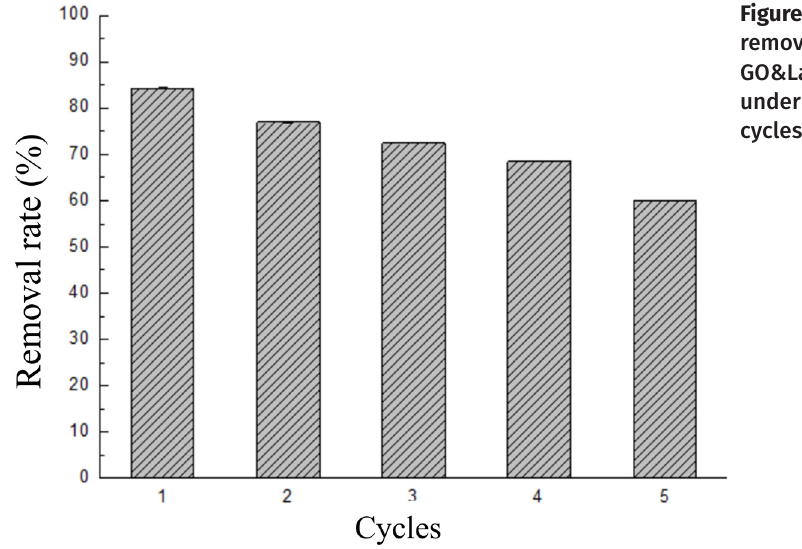
Figure 7. Colority removal rate of BDM GO&Laccase@UF under 5 consecutive